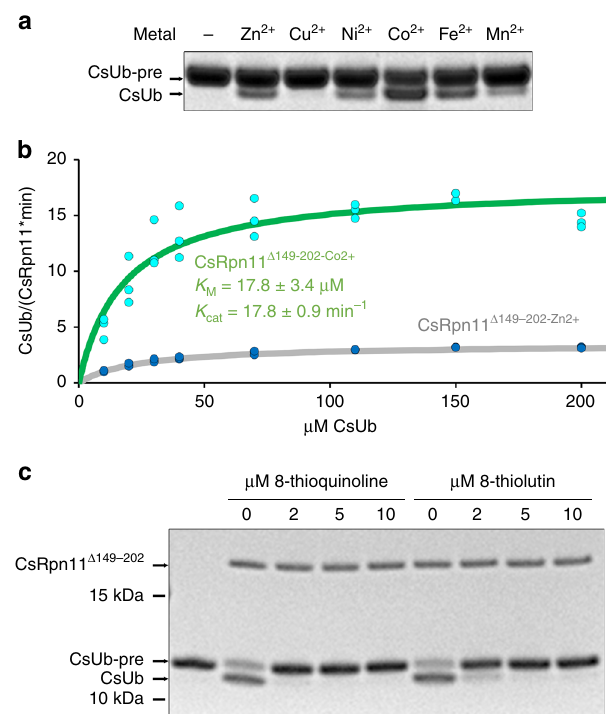
Fig. 5 CsRpn11 activity is affected by the catalytic metal ion type and inhibitors thiolutin and 8-TQ. a CsUb-pre cleavage by CsRpn11 Δ 149 – 202 in the presence of the indicated metals. The reaction was analyzed by SDS gel electrophoresis. b Michaelis – Menten plot of CsUb-pre cleavage by Co 2 + -bound CsRpn11 Δ 149 – 202 in comparison with the Zn 2 + -bound enzyme (gray, see Fig. 4d). The curves are based on three independent experiments. c An aliquot of 1.75 µ M CsRpn11 Δ 149 – 202 was incubated with the indicated concentrations of the Rpn11-speci fi c inhibitors 8-TQ 36 or thiolutin 37 and tested for activity toward CsUb-pre